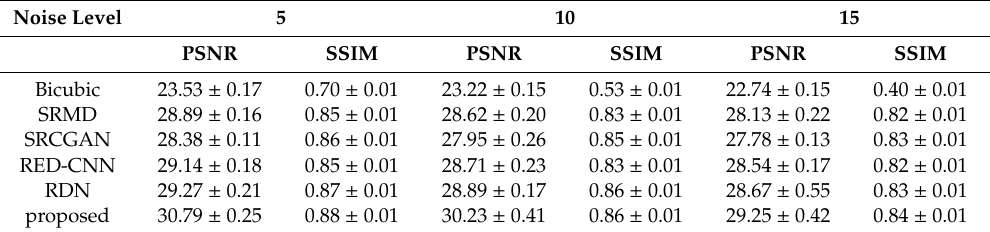
Table 4. Quantitative results (mean ± std of PSNR and SSIM) associated with different algorithms for enhancement of the qualities of images with different noise levels.